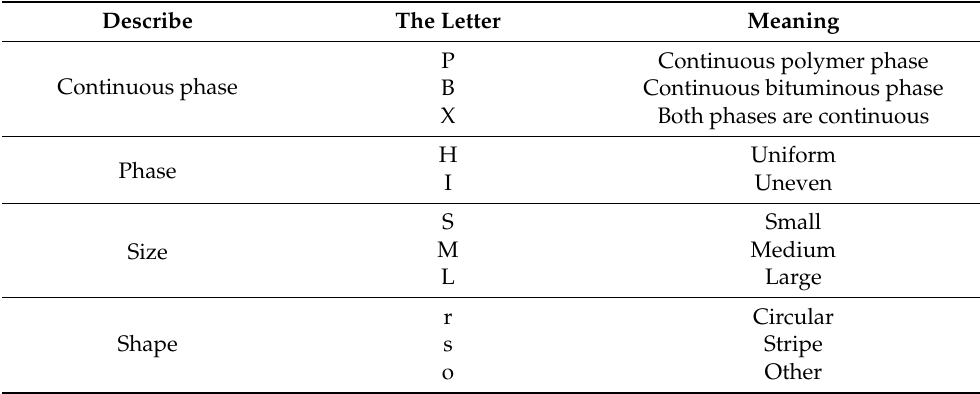
Table 11. Fluorescence microstructure meaning represented by each